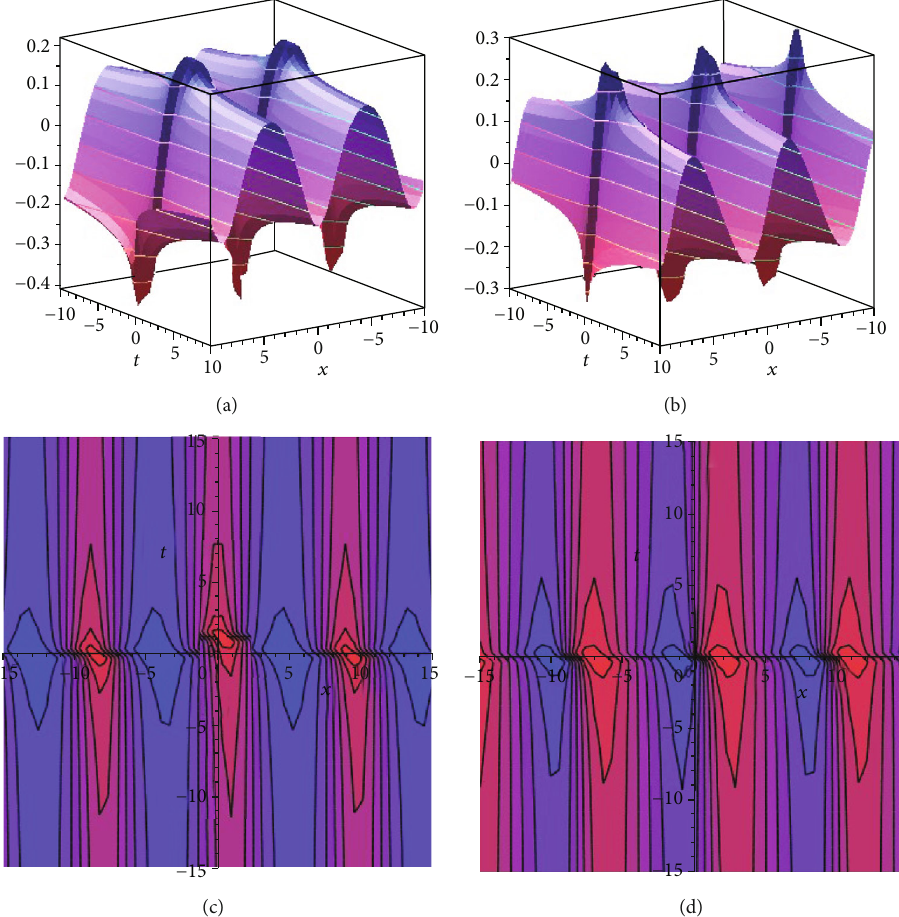
ð x , t Þ : (a) real three-dimensional shape, (b) complex three-dimensional shape, (c) 4